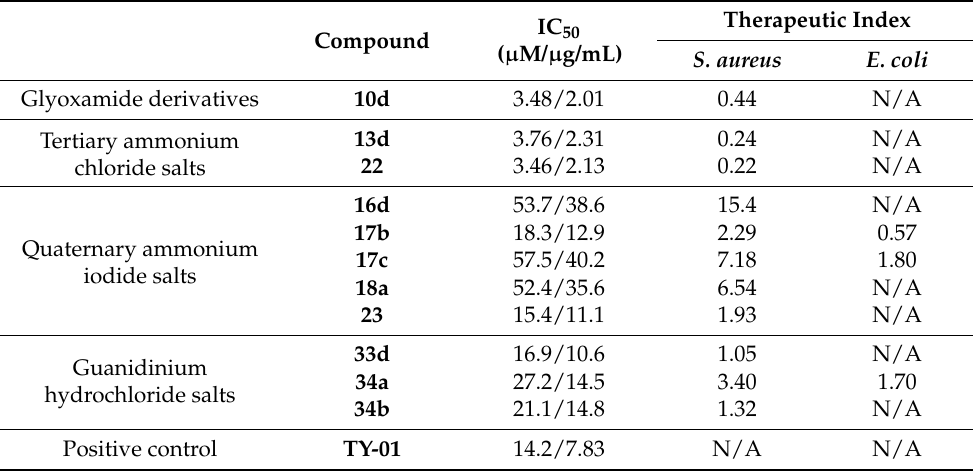
Table 2. IC 50 value of peptidomimetics against MRC-5 normal human lung fibroblasts and their therapeutic indices with respect to S. aureus and E. coli .